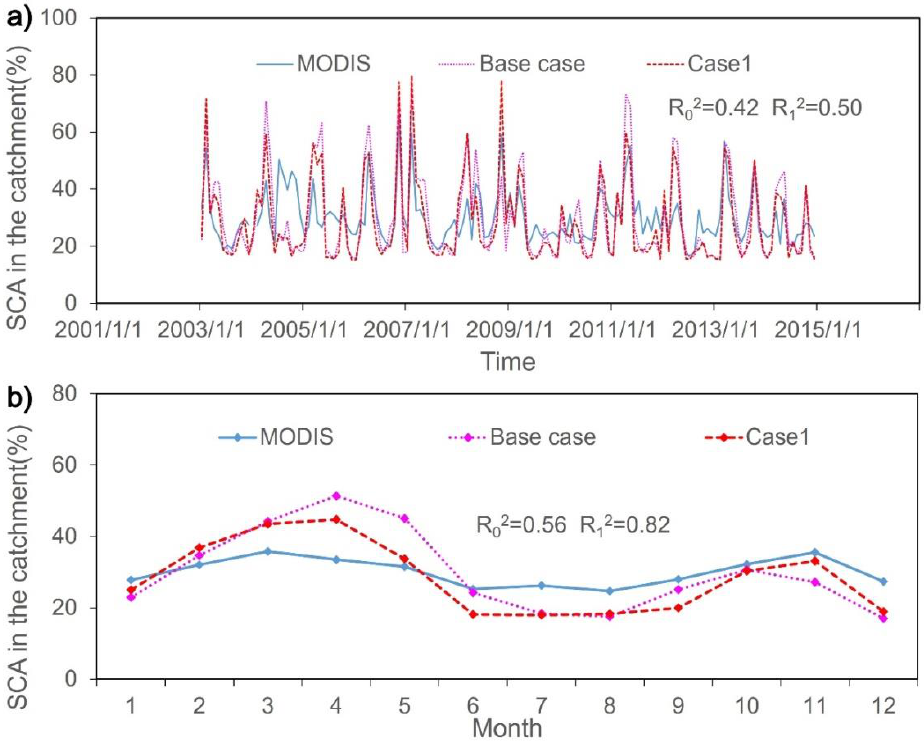
Figure 6. Comparison of the year-to-year monthly ( a ) and the multiyear-average monthly ( b ) snow cover area (SCA) simulated from the J2000 model driven by the TLRs from the traditional scheme (Base Case) and the new scheme (Case 1) during the period of 2003–2014. R 02 and R 12 are the R-squared values of Base Case and Case 1, respectively.